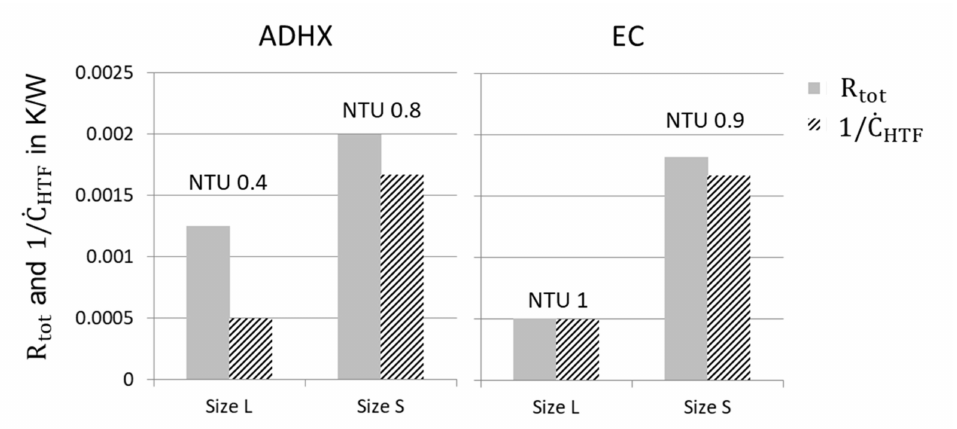
Figure 19. Heat and mass transfer resistances for measurements under 15/35/90 ◦ C temperature conditions and 300 s half cycle time. The reciprocal value of the capacity flow of the heat transfer fluid is additionally plotted for each component. The resulting NTU figure according to Equation (10) is also shown.